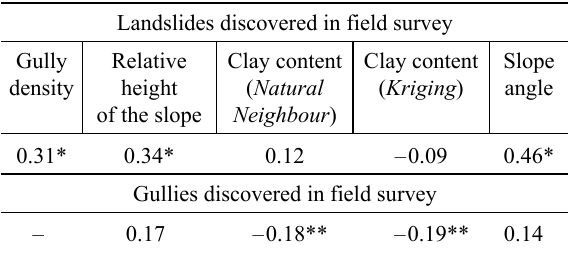
Table 2. Spearman(cid:146)s correlation between the number of